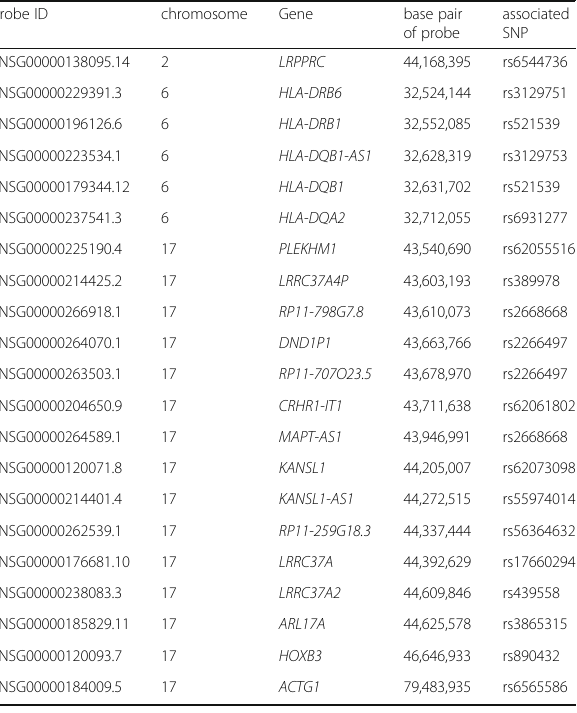
Table 7 SMR of GTEx skeletal muscle eQTLs and handgrip GWAS Table 8 GTEx Handgrip GWAS data with eQTL aggregated